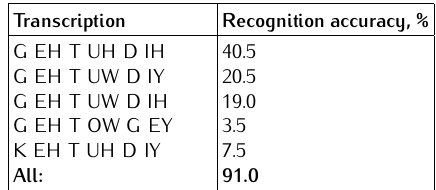
Table 5. The best iteratively selected word “Keturi” transcriptions Transcription